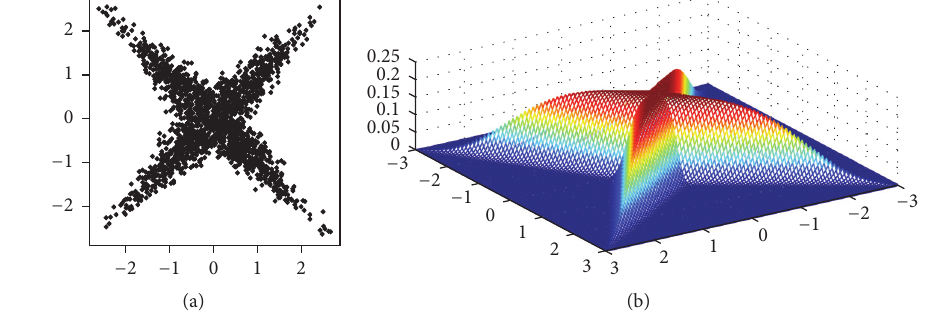
(b). 𝐾(3,0.5,1) , P 0.8